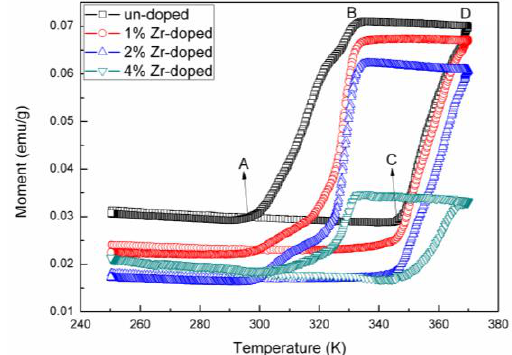
Figure 4. Moment vs. Temperature curves of un-doped, 1% Zr-doped, 2% Zr-doped and 4% Zr-doped VO 2 samples from 250 K to 370 K in a 10 k Oe magnetic field.